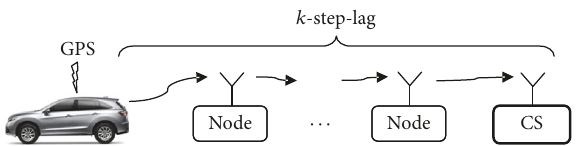
Figure 1: Transferring the time-stamped vehicle coordinates mea- sured by a GPS tracker to a central station (CS) via several nodes of a WSN. Latency with a 𝑘 𝑛 -step-lag is caused by delays in the node.